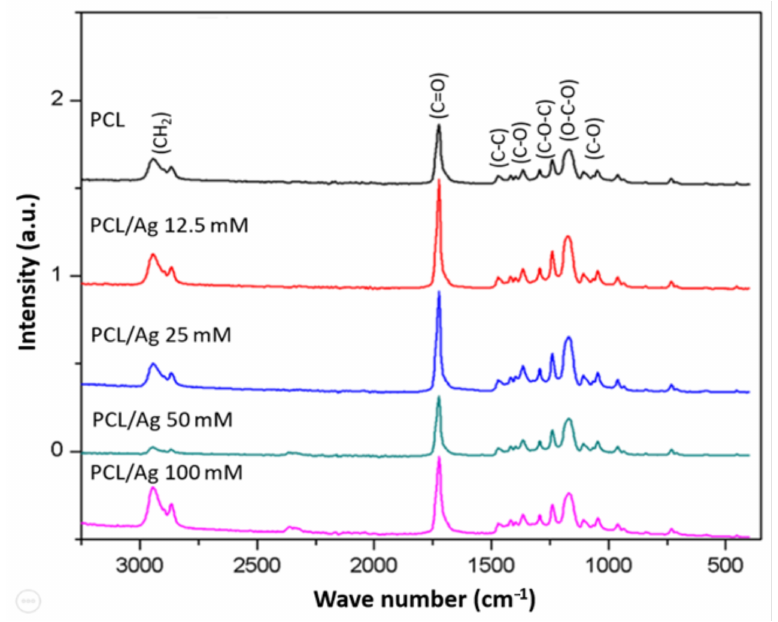
Figure 1. Infrared spectrum obtained from the different nanofibers of PCL/Ag (poly- ε -